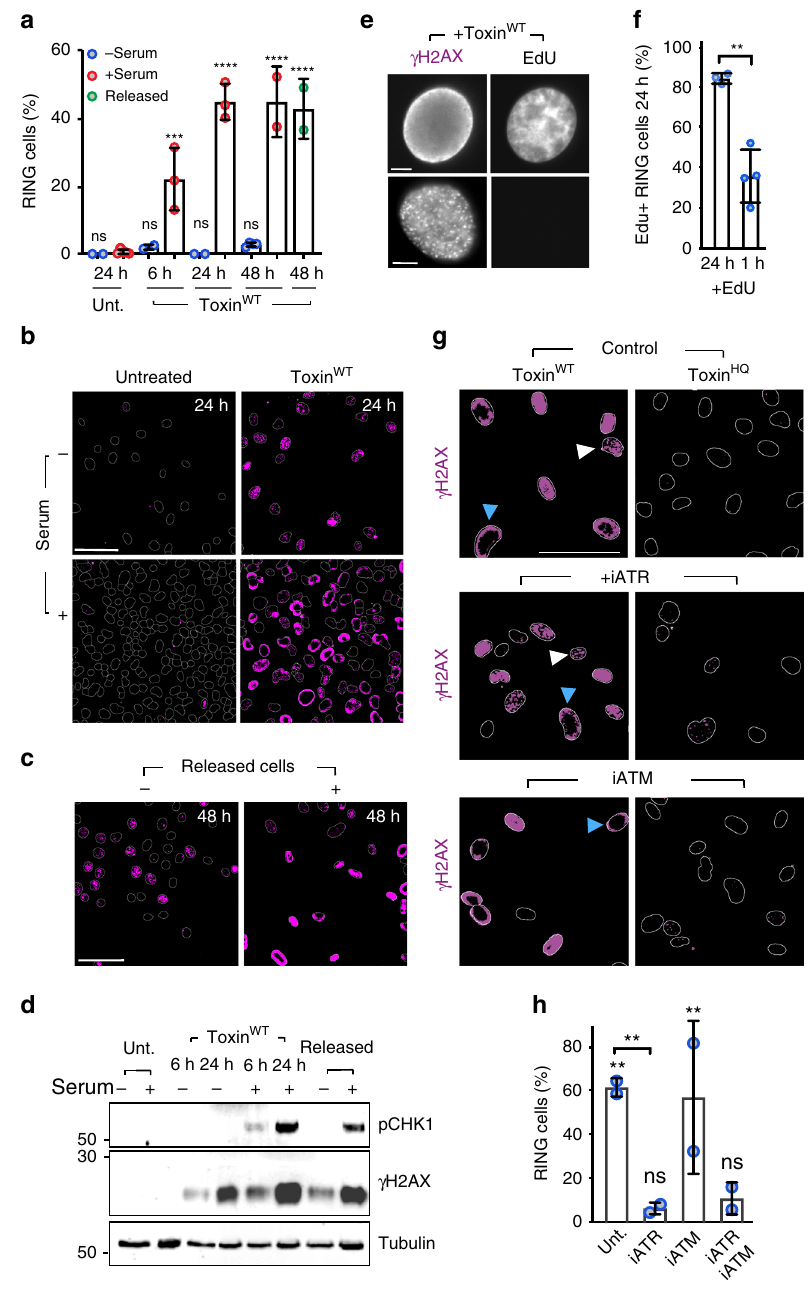
Fig. 2 RINGs are triggered during S-phase of the cell cycle. a Proportion of toxin-induced γ H2AX RINGs in non replicating ( − serum, blue circle) or replicating ( + serum, red circle) HT1080 cells. Untreated control cells are shown. Serum-starved cells were incubated with serum from 24 h as indicated (released, green circle). Coloured circles indicate means from at least two biological replicates (2000 nuclei per variable). b Representative image of γ H2AX RINGs± serum at 24 h. γ H2AX labelled in magenta. Outlines of DAPI-stained nuclei shown. Scale bars 50 μ m. c Representative image of γ H2AX RINGs in released cells. Labelled as B. Scale bars 50 μ m. d Representative immunoblot of toxin-induced phosphorylation of CHK1 (pCHK1) and H2AX ( γ H2AX) ± serum at 6 or 24, or 48 h (released). MW in kDa left. e Representative image of EdU-labelled DNA in γ H2AX RING or foci cells at 24 h. EdU incubated for 24 h. Scale bars 5 μ m. f Proportion of γ H2AX RING cells with EdU-labelled DNA at 24 h. EdU incubated for 24 h or 1 h before fi xation. Circles indicate means from at least three biological replicates (>220 nuclei per condition). g Representative image of γ H2AX RINGs (blue arrow) or foci (white arrow) in the presence of DMSO (control), ATR inhibitor (iATR), or ATM inhibitor (iATM) shown with outlines of DAPI-stained nuclei. Toxin HQ used as negative control. Scale bars 50 μ m. h Proportion of γ H2AX RINGs in presence of ATR/ATM inhibitors at 24 h. Control toxin HQ -treated cells are shown. Circles indicate means from two biological replicates (470 nuclei per variable). Statistical signi fi cance (**** = P < 0.0001, *** = P < 0.0002, ** = P < 0.0021, * = P < 0.0332, ns = P > = 0.05) was calculated relative to corresponding control (unt, + serum in a ; toxin HQ in h ) using one-way ANOVA and a Tukey ’ s multiple comparison test ( a , h ), or between samples using an unpaired two-sided t test ( f ). Error bars SD. Source data are provided as a Source Data fi